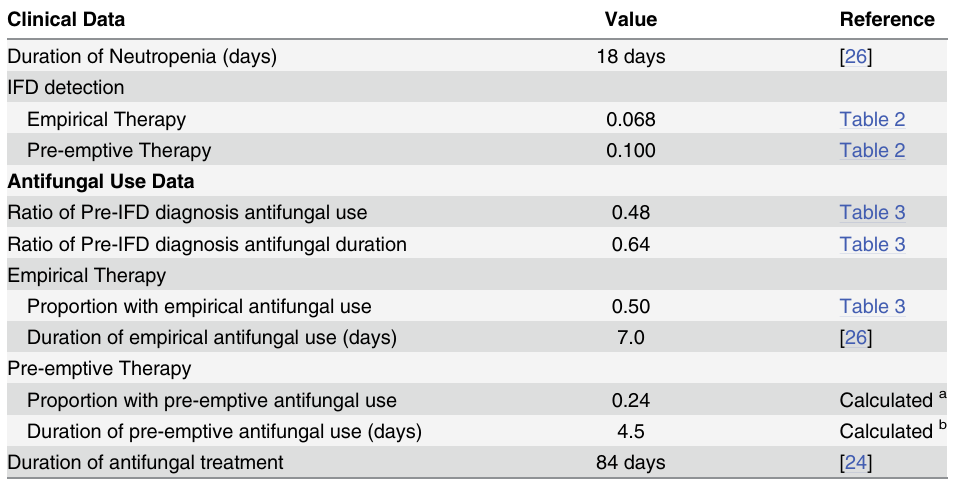
Table 4. Clinical parameters incorporated into cost comparison model.